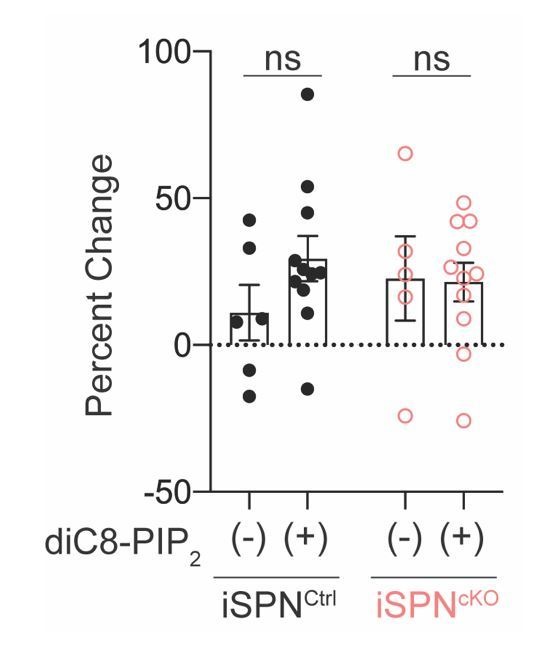
Increasing cellular PIP2 levels does not rescue Kir2 currents in Atg7-deficient iSPNs.(A) diC8-PIP2 (50 μM) was included in the intracellular solution. Percent change in Kir2 currents after 12 minutes of dialysis with the internal solution ((Lieberman et al., 2018). No effect of diC8-PIP2 was found in either genotype. Data analyzed with two-way ANOVA followed by Bonferroni test. Genotype x PIP2: F(1,29)=1.124, p=0.2978; Genotype: F(1,29)=0.8626, p=0.3607; PIP2: F(1,29)=0.03962, p=0.8436. Each condition arose from >3 mice each.